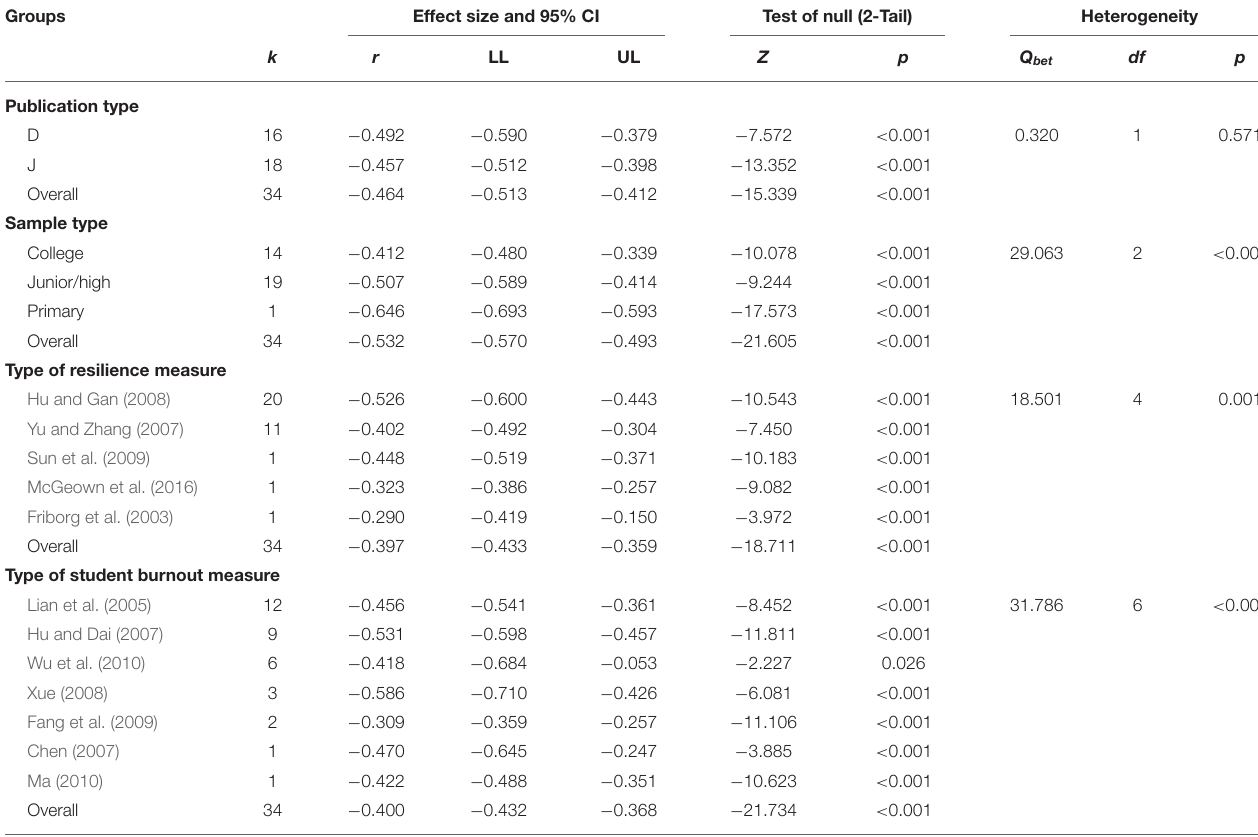
TABLE 6 | Moderations on the relationship between resilience and student burnout. Groups